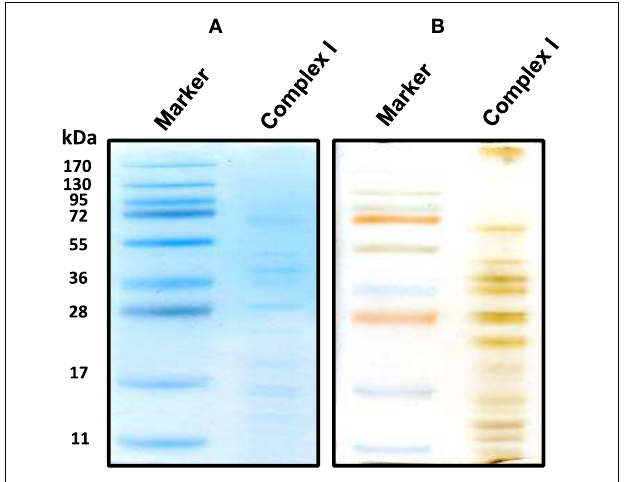
FIGURE 3 | An alternative second dimensional SDS-PAGE approach whereby the complex I band derived from the gels shown in Figure 1 was placed on top of the second dimensional SDS gel. Both CBB staining (A) and silver staining (B) of complex I proteins bands were shown.